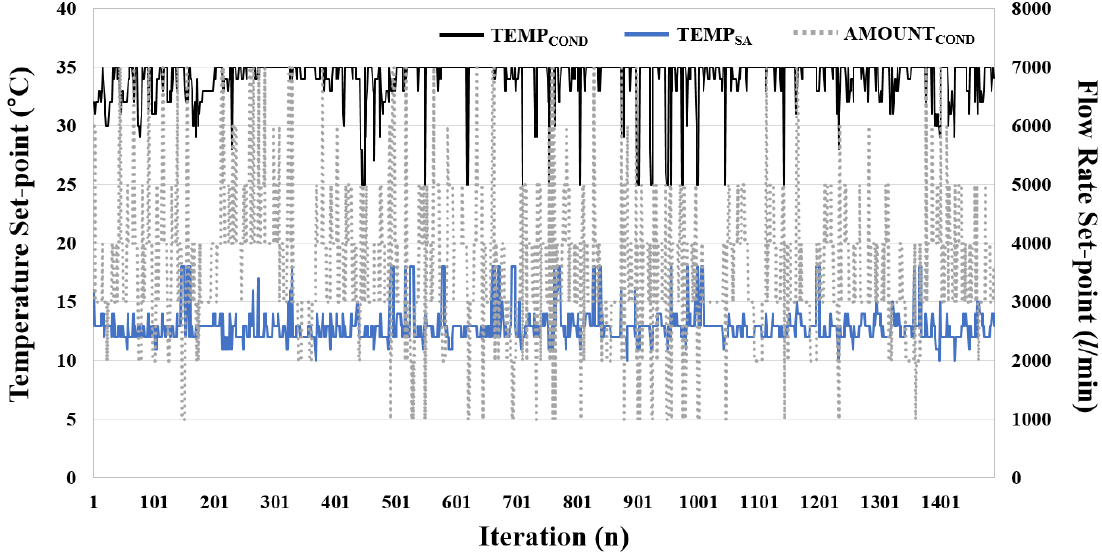
Figure 13. Optimal set-points of the system variables.